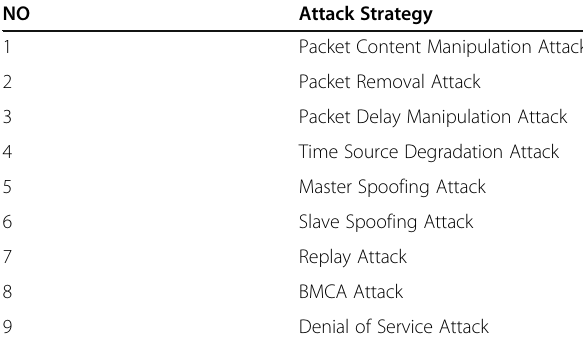
Table 1 PTP Attack